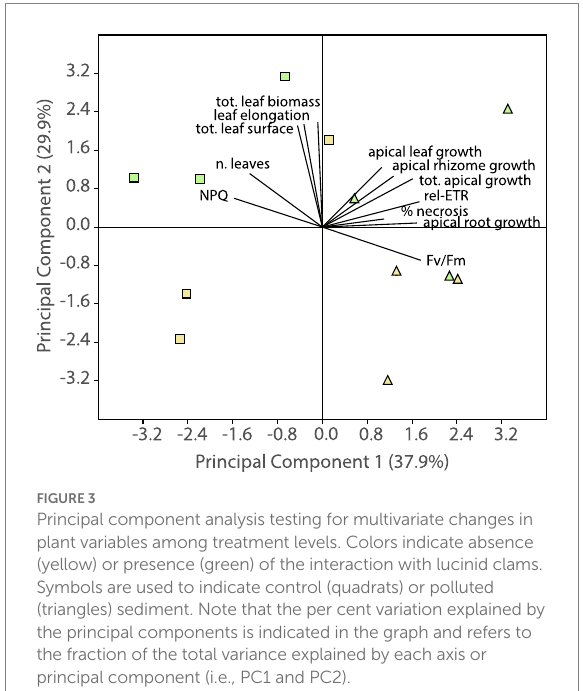
FIGURE 3 Principal component analysis testing for multivariate changes in plant variables among treatment levels. Colors indicate absence (yellow) or presence (green) of the interaction with lucinid clams. Symbols are used to indicate control (quadrats) or polluted (triangles) sediment. Note that the per cent variation explained by the principal components is indicated in the graph and refers to the fraction of the total variance explained by each axis or principal component (i.e., PC1 and PC2).